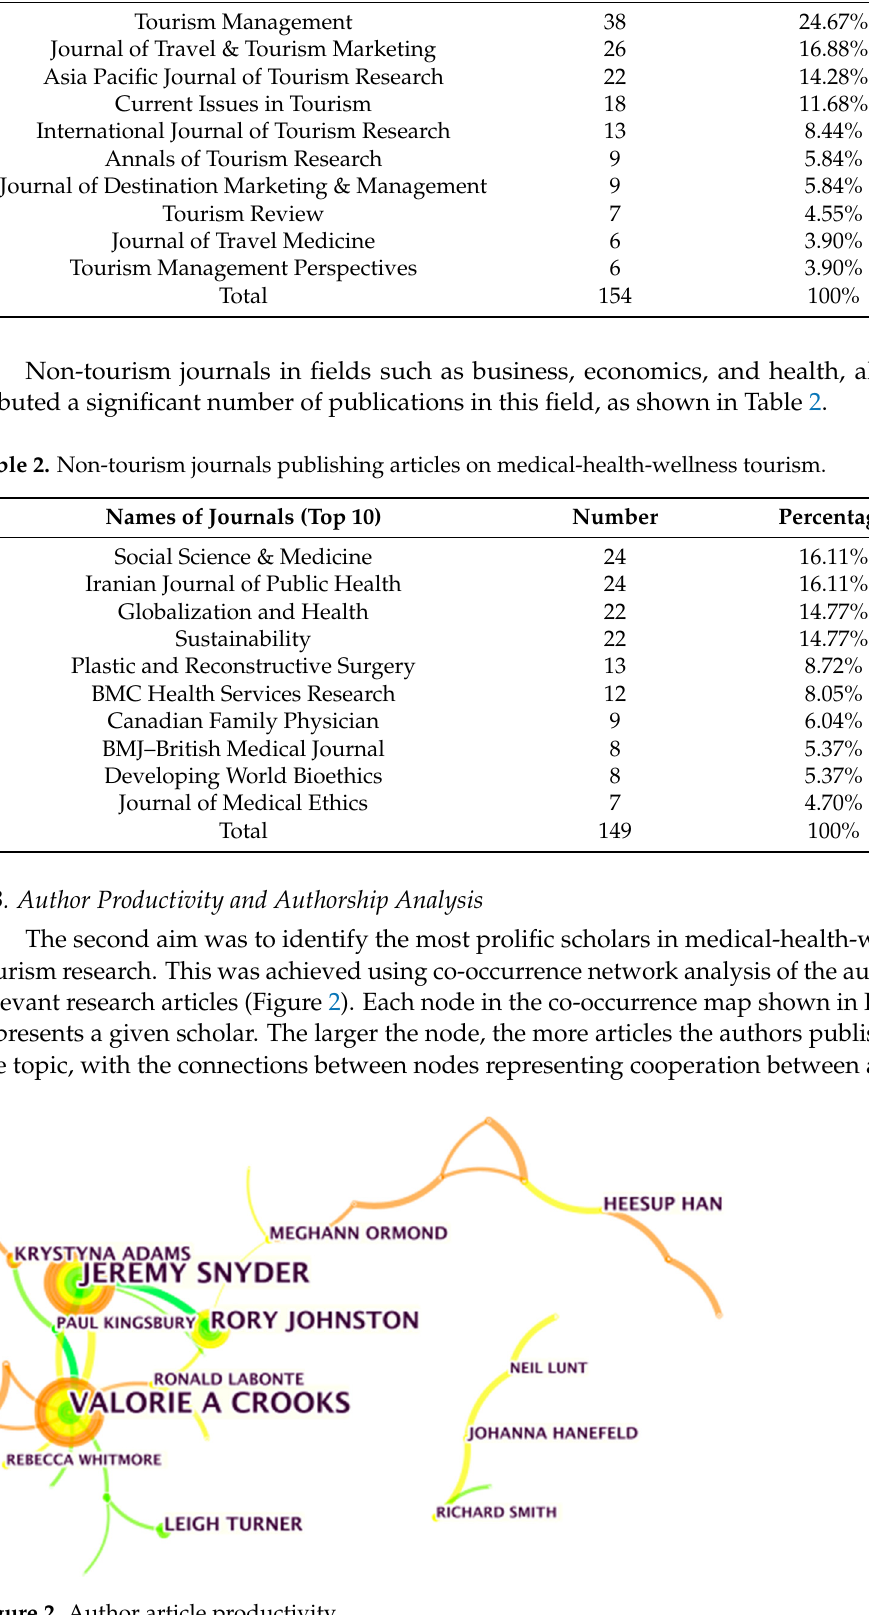
Figure 2. Author article